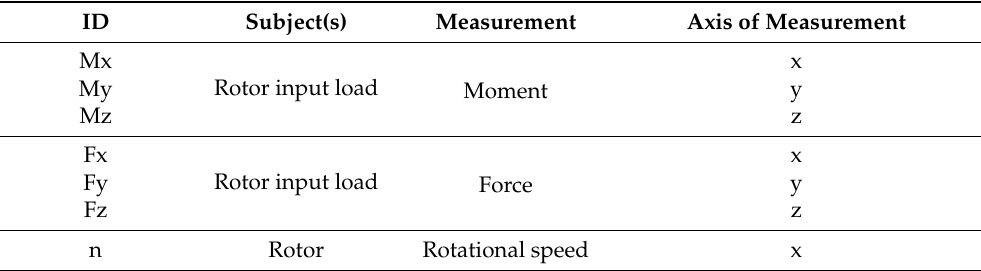
Figure 3. Overview of proposed methodology for generation of factor combinations for V52 drivetrain testing. Table 1. Explanation of experimental factors under investigation.